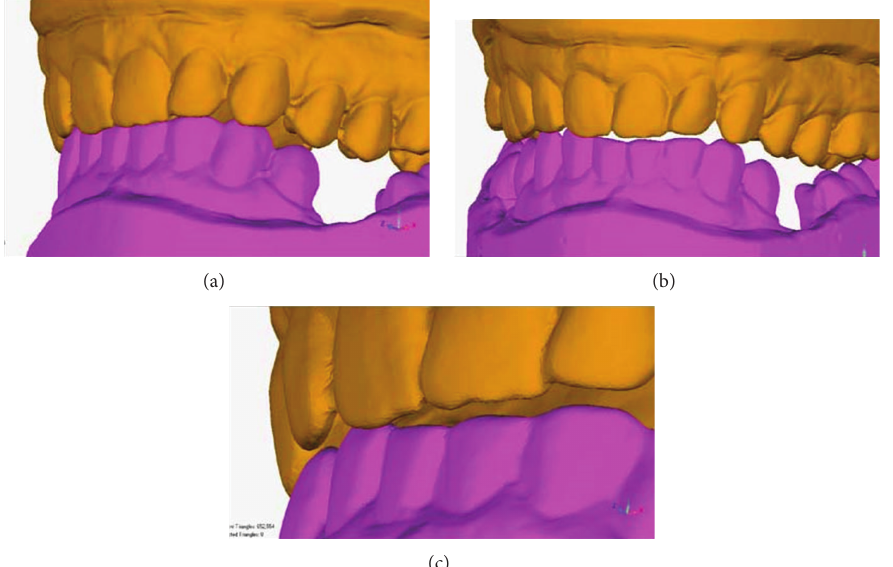
Figure 8: Three screen shots from a 4D animation of protrusion (a) shows the closed position, (b) an intermediate position, and (c) shows the single contact sliding on the right lateral